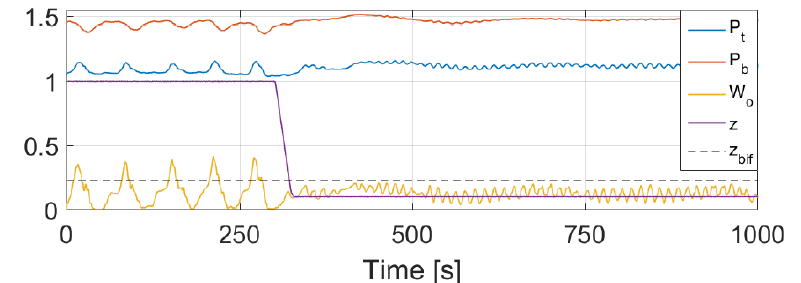
Figure 2. A choke valve (z) step test from 100% (slug flow) to 10% (non-slug flow) opening at 300 s. The open-loop bifurcation point is located at z = 23.4% illustrated by the black dashed line. The riser top pressure ( P t ) in bar is the blue characteristic, The riser bottom pressure ( P b ) in bar is the red characteristic, and the mass flow out of the system ( w o ) measured by a Coriolis mass flow transmitter in kg/s is the yellow